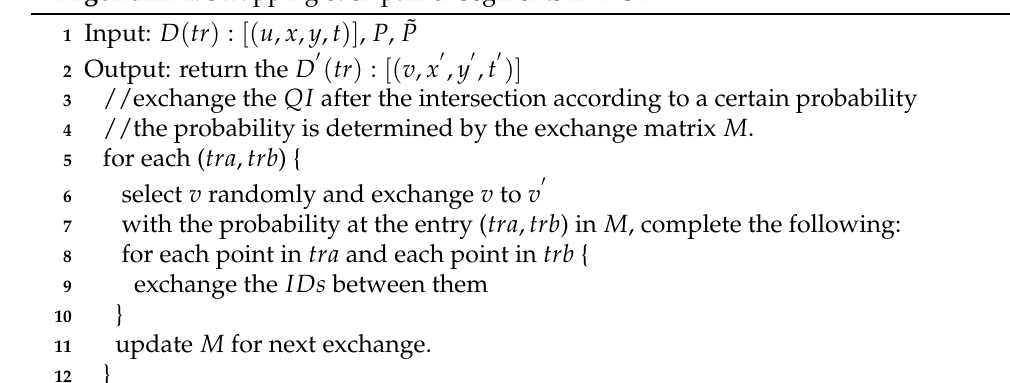
Algorithm 4: Swapping each pair of segments in P ∪ ˜ P